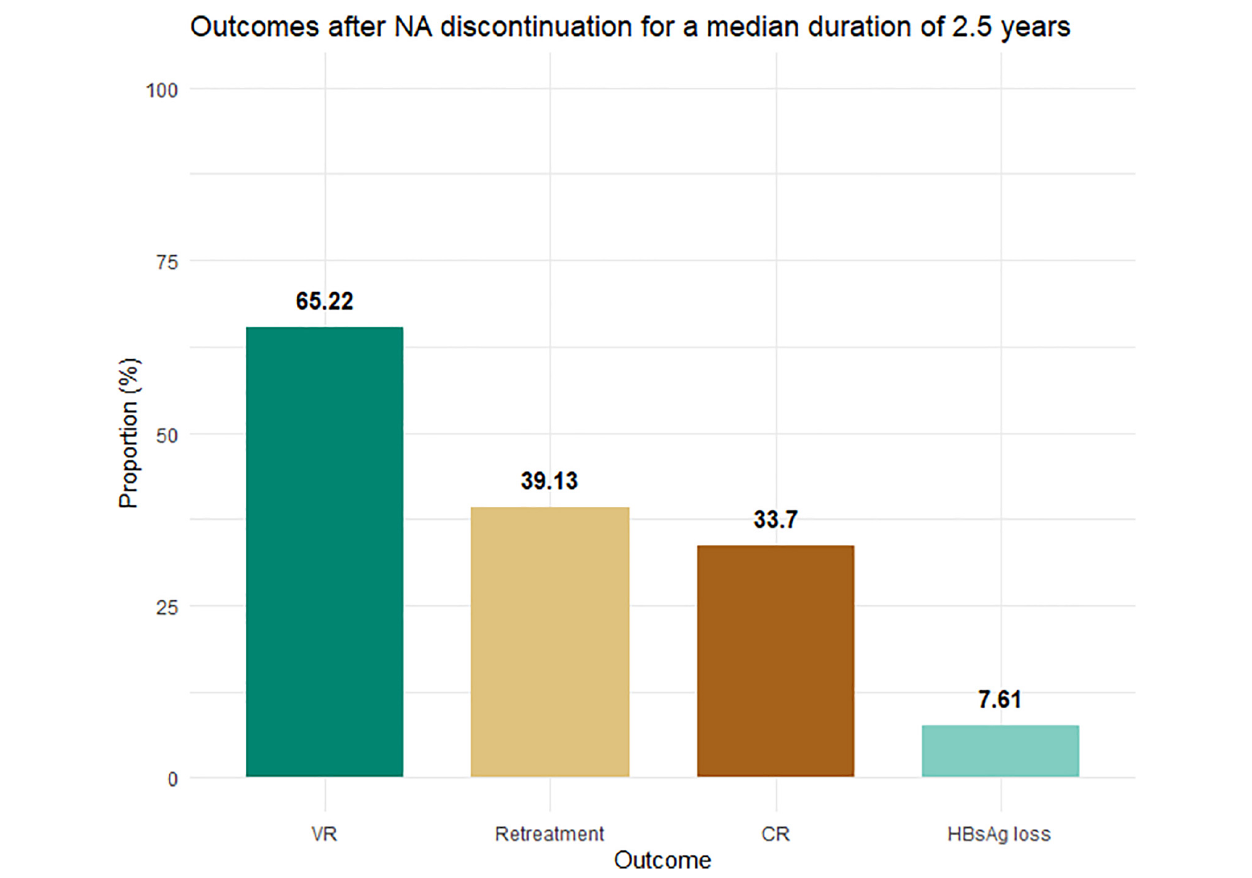
FIGURE 1 | Proportion of patients experiencing virological relapse, CR, retreatment, and HBsAg loss. NAs, nucleos(t)ide analogs; ULN, upper limit of normal (33 U/L for men and women). Virological relapse was defined by serum HBV DNA levels > 2,000 IU/ml. CR was defined as virological relapse plus serum alanine aminotransferase levels > 2 × ULN. HBsAg loss was defined by an undetectable HBsAg